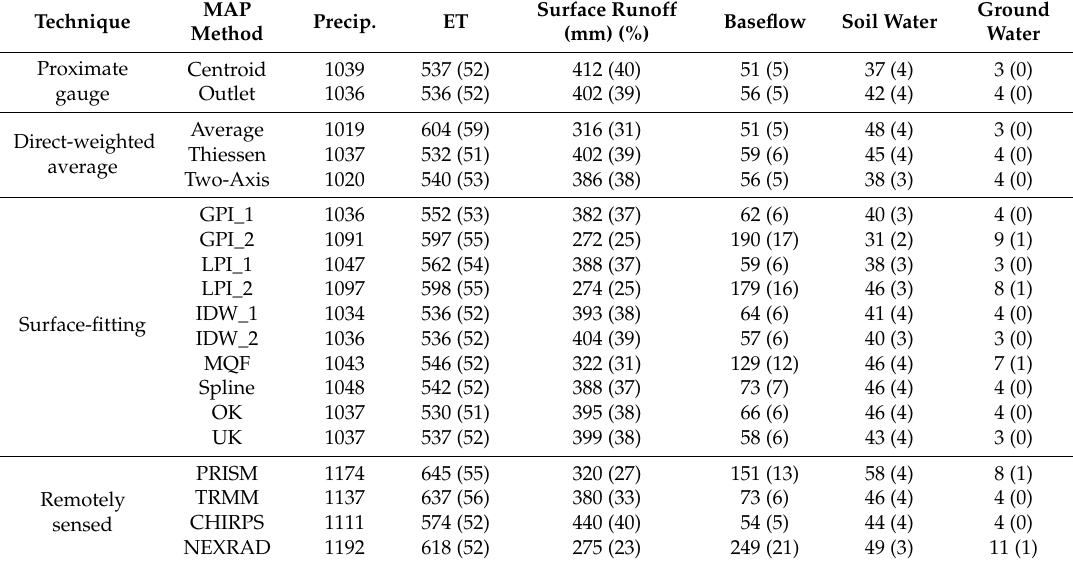
Table 9. Mean areal precipitation (MAP) input effects on water balance variables after SWAT model calibration in the Hinkson Creek Watershed, Missouri, USA. SWAT models were forced with 19 different precipitation methods. All results are shown in depth of water (mm). The percent of total water input is shown parenthetically. Precip. is precipitation, ET is evapotranspiration, and Ground water is deep aquifer